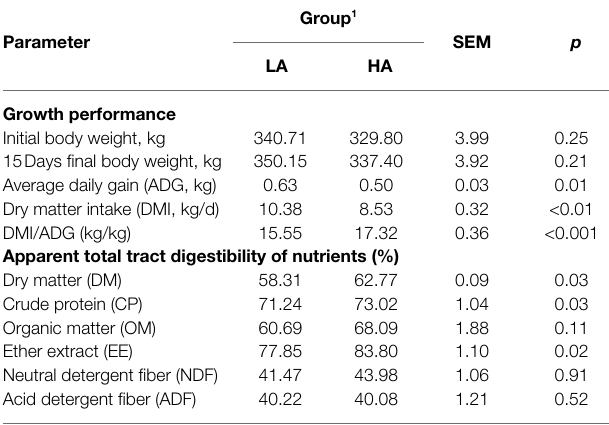
TABLE 2 | Effect of altitude on the serum antioxidant enzyme activities and oxidant products in Sanhe heifers.